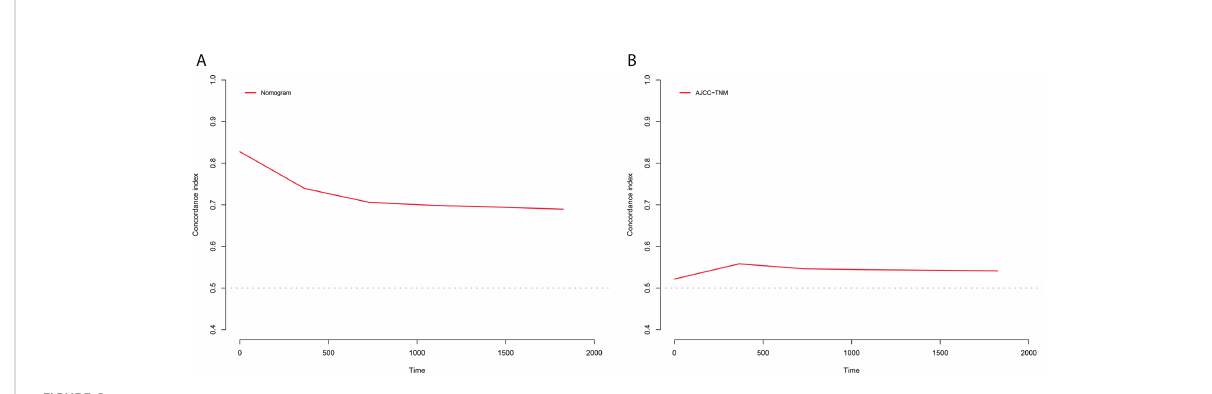
FIGURE 6 C-index results, (A) The C-index based on the nomogram; (B) The C-index based on the AJCC tumor staging.